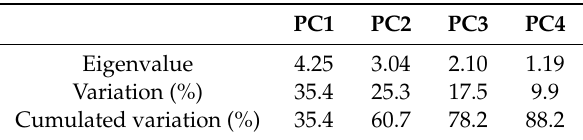
Table 4. Eigenvalues, share in total variation and cumulative share in total in the data of the first four principal components.